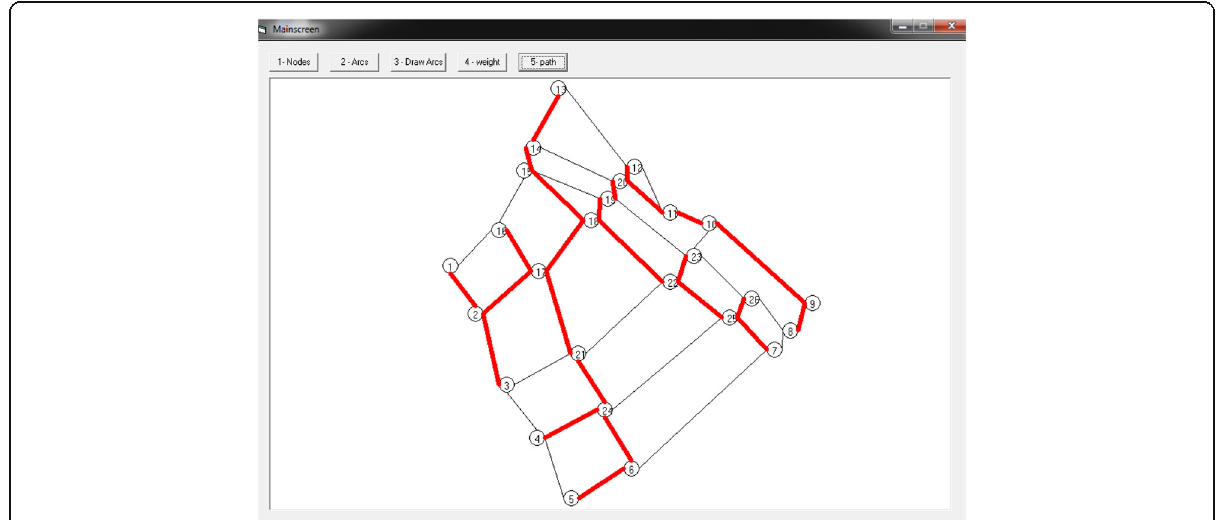
Fig. 25 The Results Derived from Implementing the Model of Main Indices on the Sample Data using